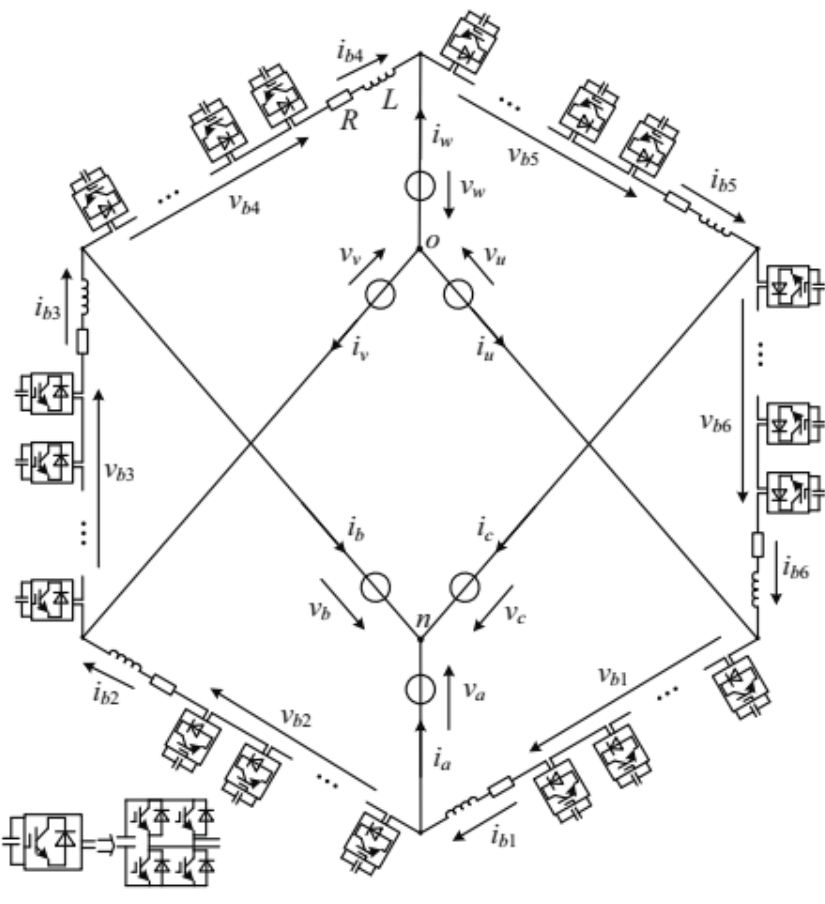
Figure 3. The hexverter converter.